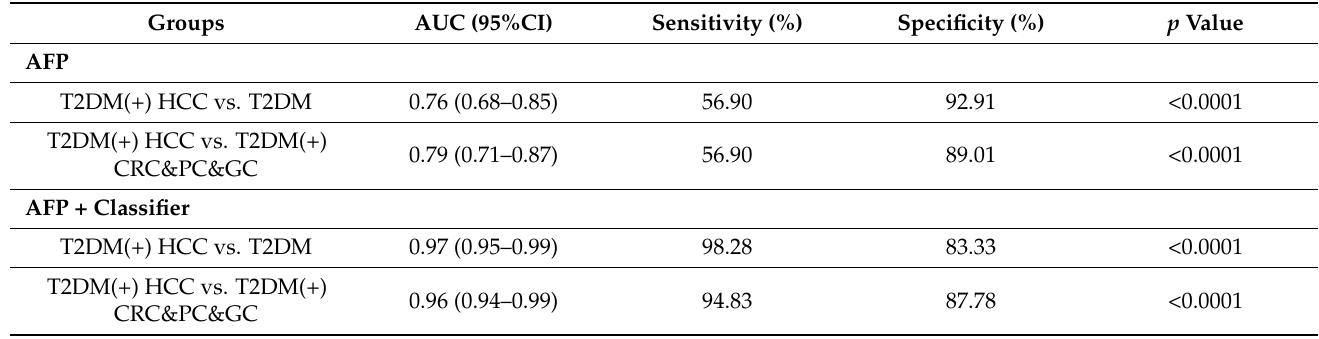
Table 7. The combination of the metabolite classifier and AFP for T2DM(+) HCC